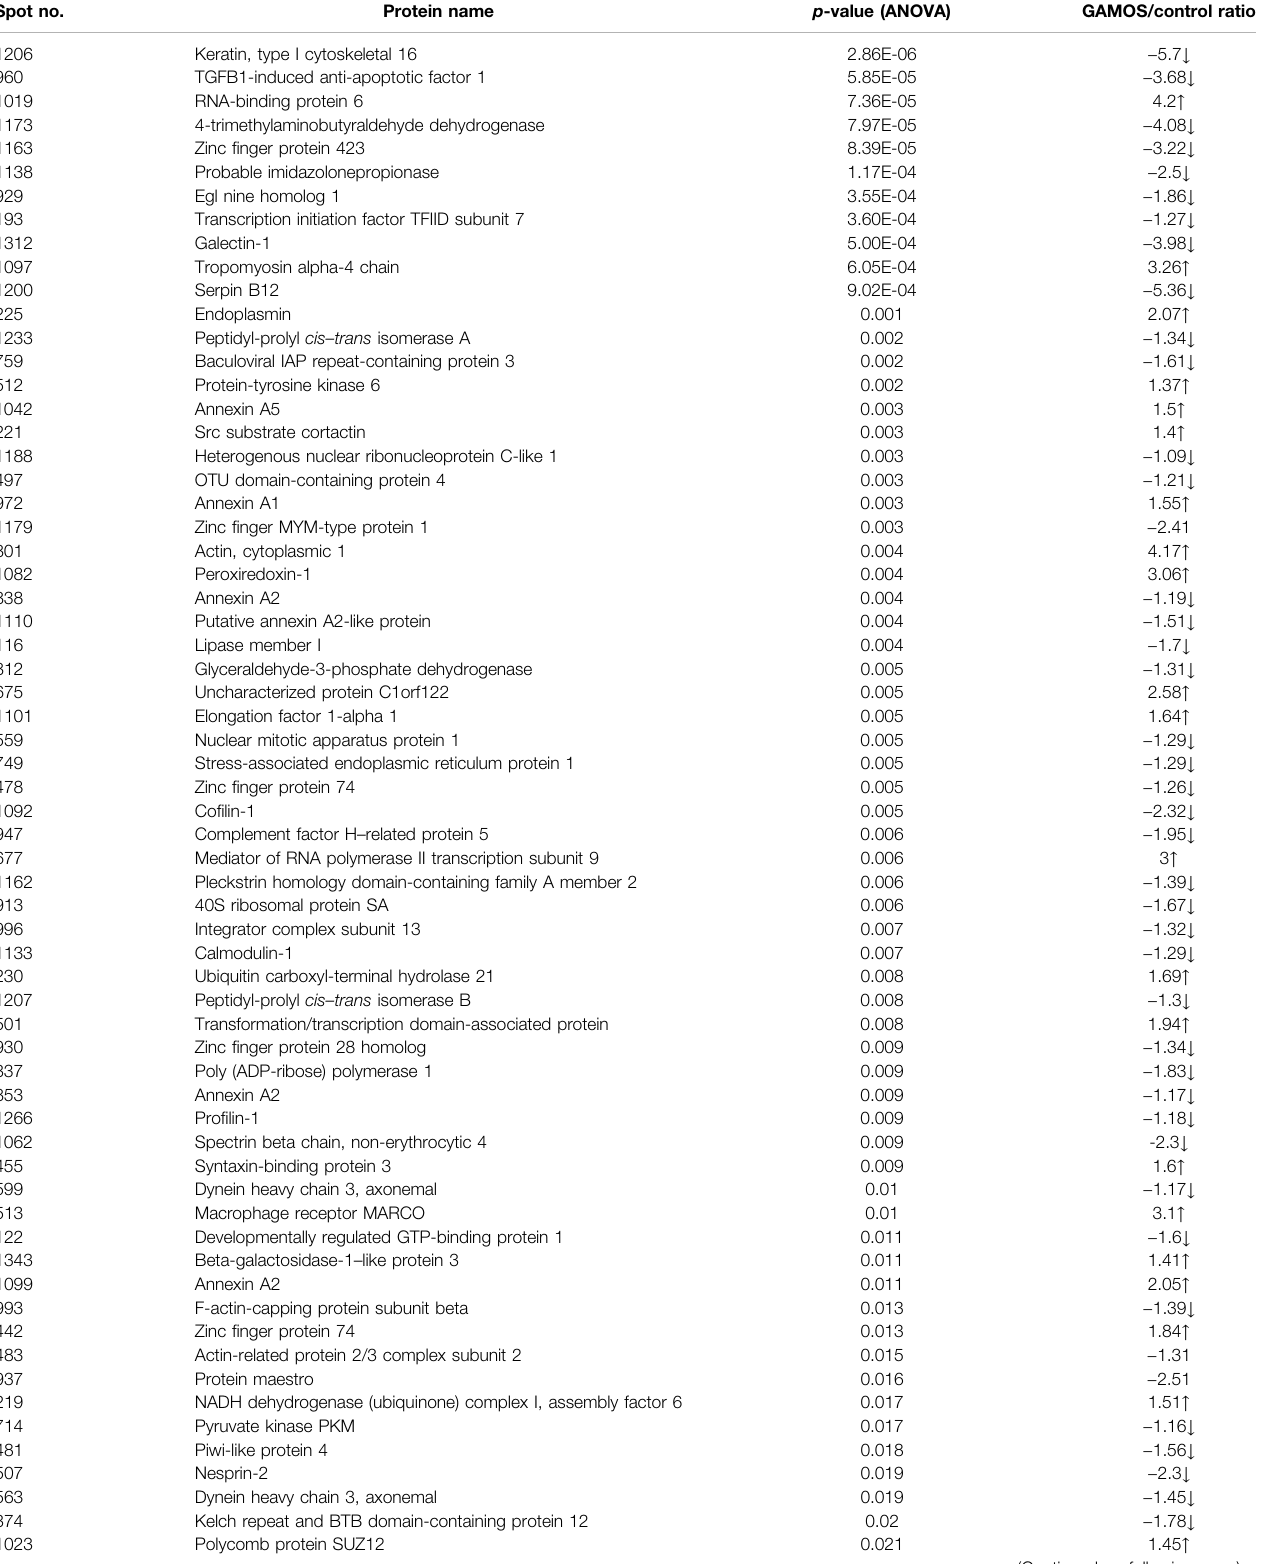
TABLE 2 | Identi fi ed proteins, with changes in abundance between the control and patients with GAMOS. Spot